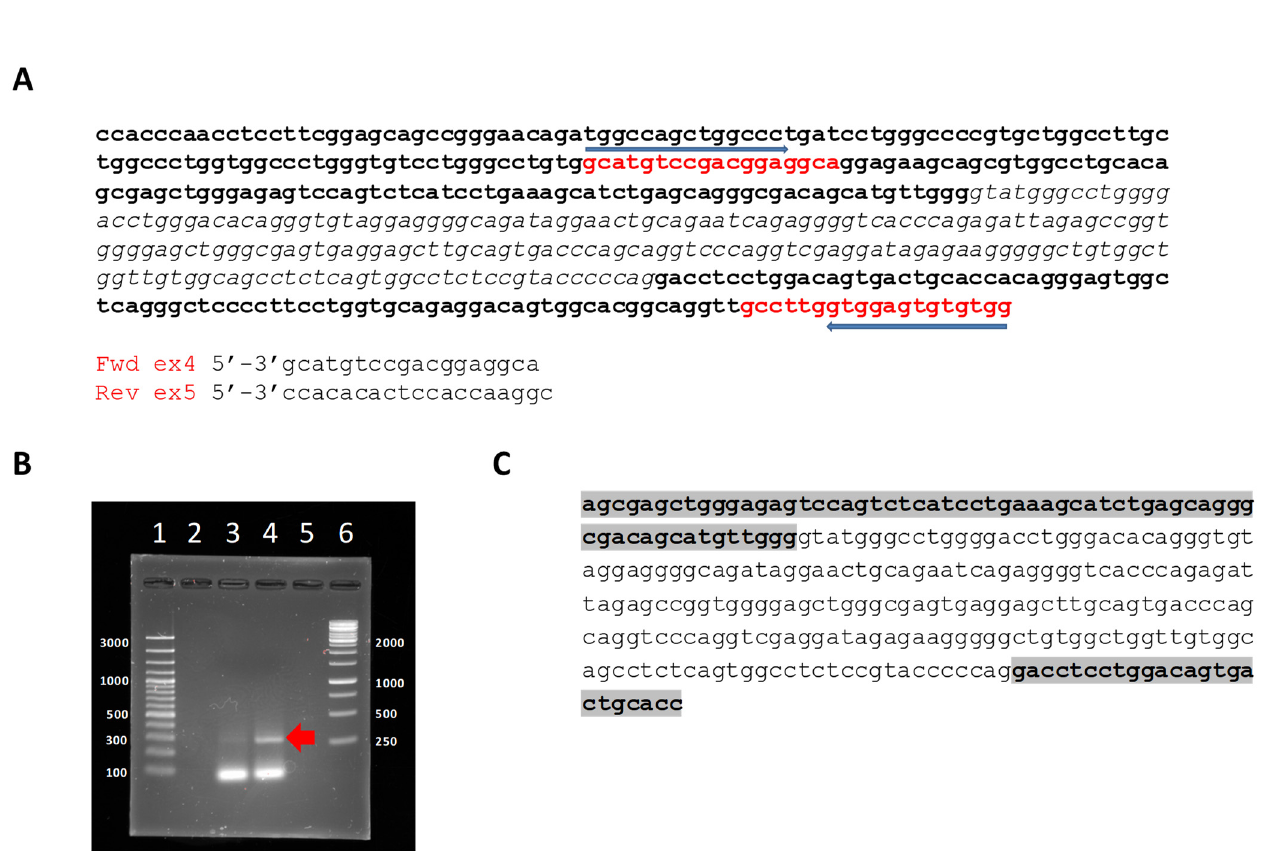
Figure 4. ( A ) DNA sequence of the terminal part of exon 4, intron IV and the beginning of exon 5 of the ACVRL1/ALK1 gene. Sequence of the forward and reverse primers used for PCR amplification show the alignment region within this DNA sequence. ( B ) PCR of the cDNA from HHT and unaffected relative showing, in the case of HHT, the presence of an abnormal band > 250 bp corresponding to the species containing intron IV of ALK1 (highlighted by a red arrow). ( C ) Sequence of exon 4 border and intron IV of ALK1 obtained from the >250 bp band shown in B. Marker sizes are shown.